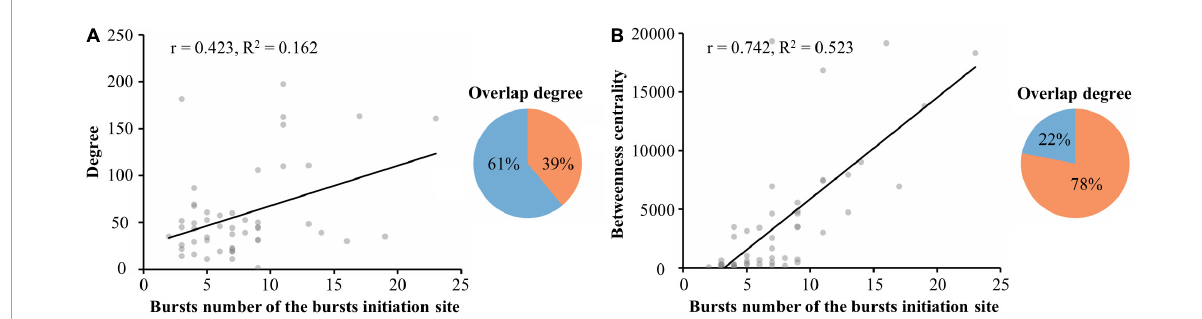
FIGURE6 Altering the excitatory-inhibitory balance allowed further exploration of the relationship between spontaneous bursts and hubs. (A) Linear regression of the number of bursts at burst onset and the average degree of the learning population within 115 µ m of the burst onset (left). The overlap between neurons involved in the burst onset and those in the learning population with the top 90% modularity (right). (B) Linear regression of the number of bursts at burst onset and the average betweenness centrality of the learning populations within 115 µ m of the burst onset (left). The overlap between neurons involved in the burst onset and those in the learning population with the top 90% betweenness centrality (right) ( n = 5 cultures, time: 5 min, n = 387